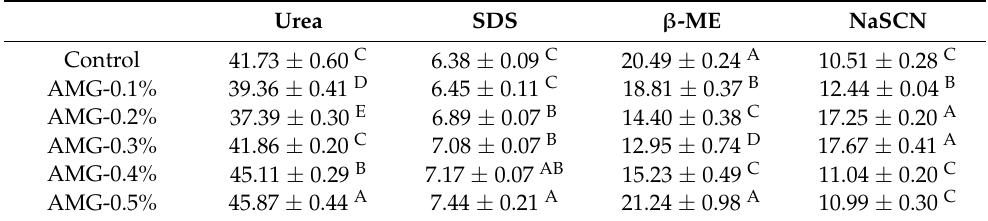
Table 6. Solubility (%) of frankfurters with or without AMG at different concentrations in different force-disruption